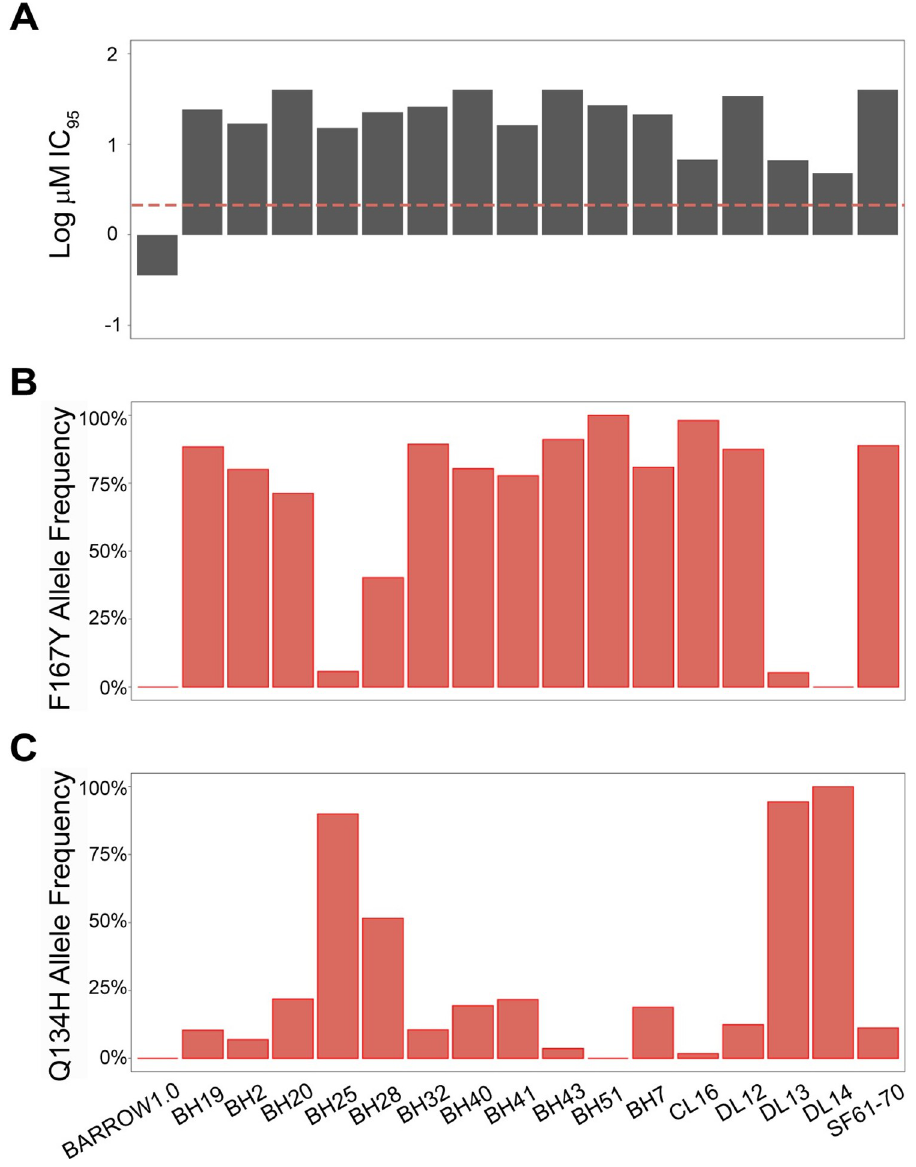
Fig 1. Egg hatch assay and isotype-1 β -tubulin 167Y(TAC) and 134H(CAT) mutation frequency data for 16 A . caninum samples from 25 greyhounds. (A): Log-transformed Egg Hatch Assay (EHA) IC 95 values ( μ M) for the 16 A . caninum fecal egg samples. The resistance threshold is indicated by the red dashed line; (B): 167Y(TAC) isotype-1 β - tubulin mutation frequencies; (C): 134H(CAT) isotype-1 β -tubulin mutation frequencies. Sample SF61-70 is a pool comprising A . caninum from 10 greyhounds. Barrow 1.0 is the first passage of an A . caninum benzimidazole- susceptible laboratory sample [10]. The remaining samples are from 25 greyhounds described in [12].